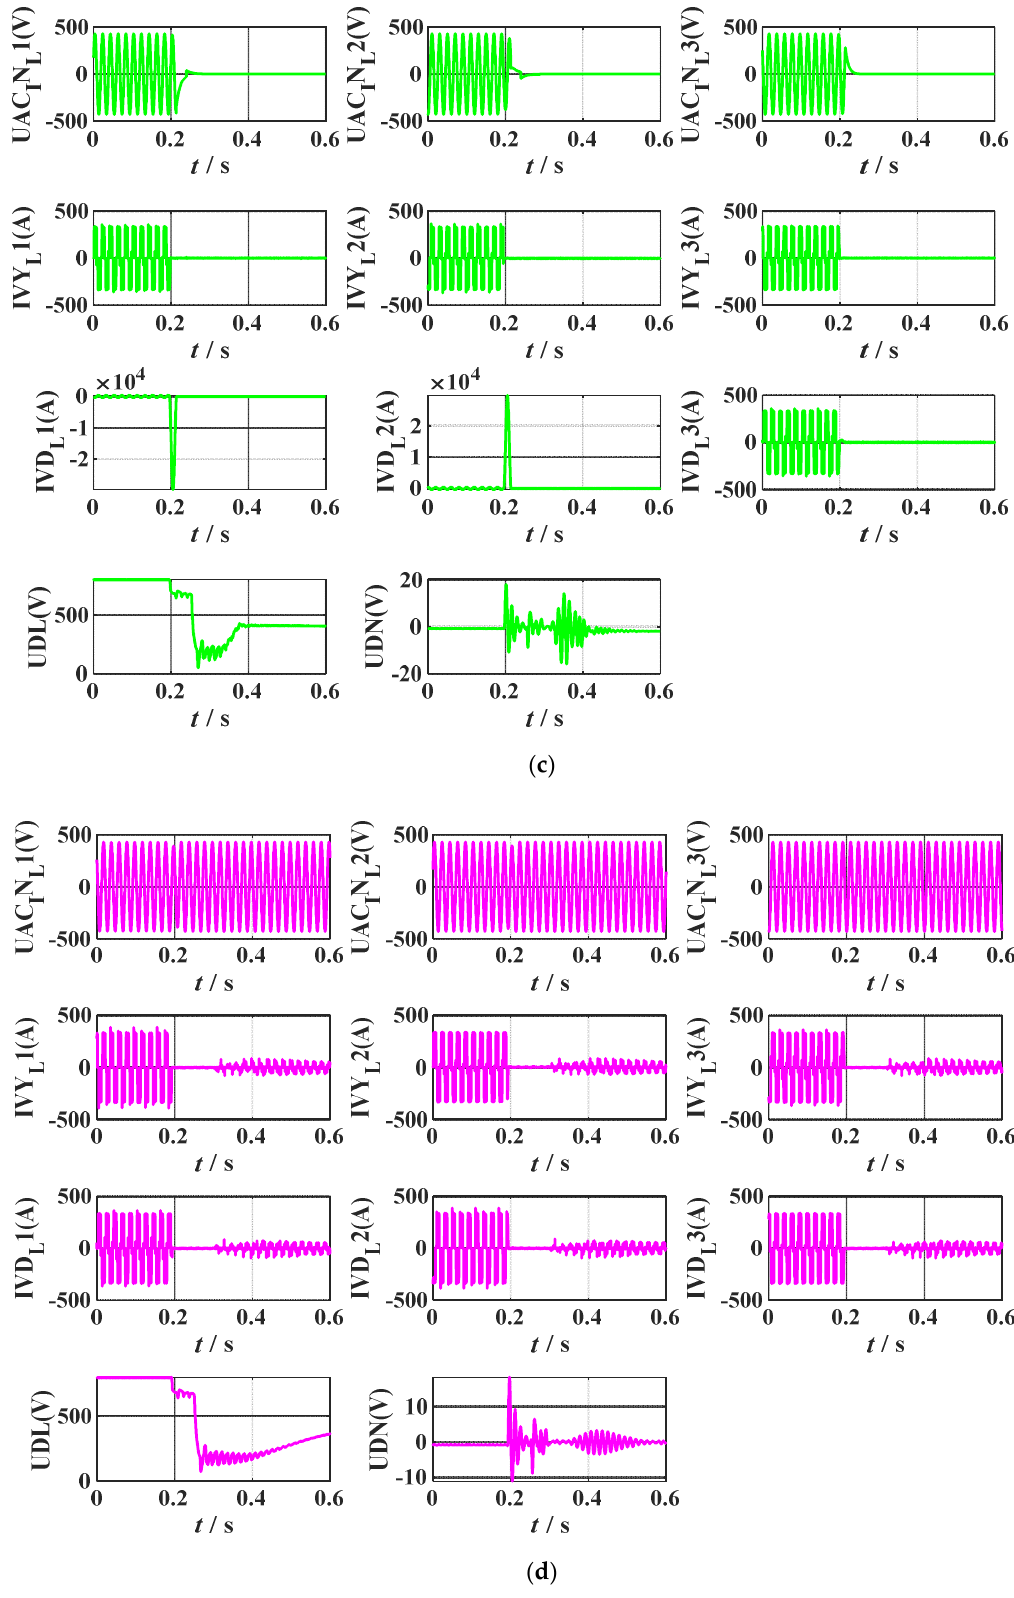
Figure 6. Diagnosis waveforms of four types of HVDC faults: ( a ) DC−side transmission line single- phase fault data, ( b ) DC−side transmission line interphase fault data, ( c ) fault data of converter valve arm, and ( d ) fault data of converter valve group.